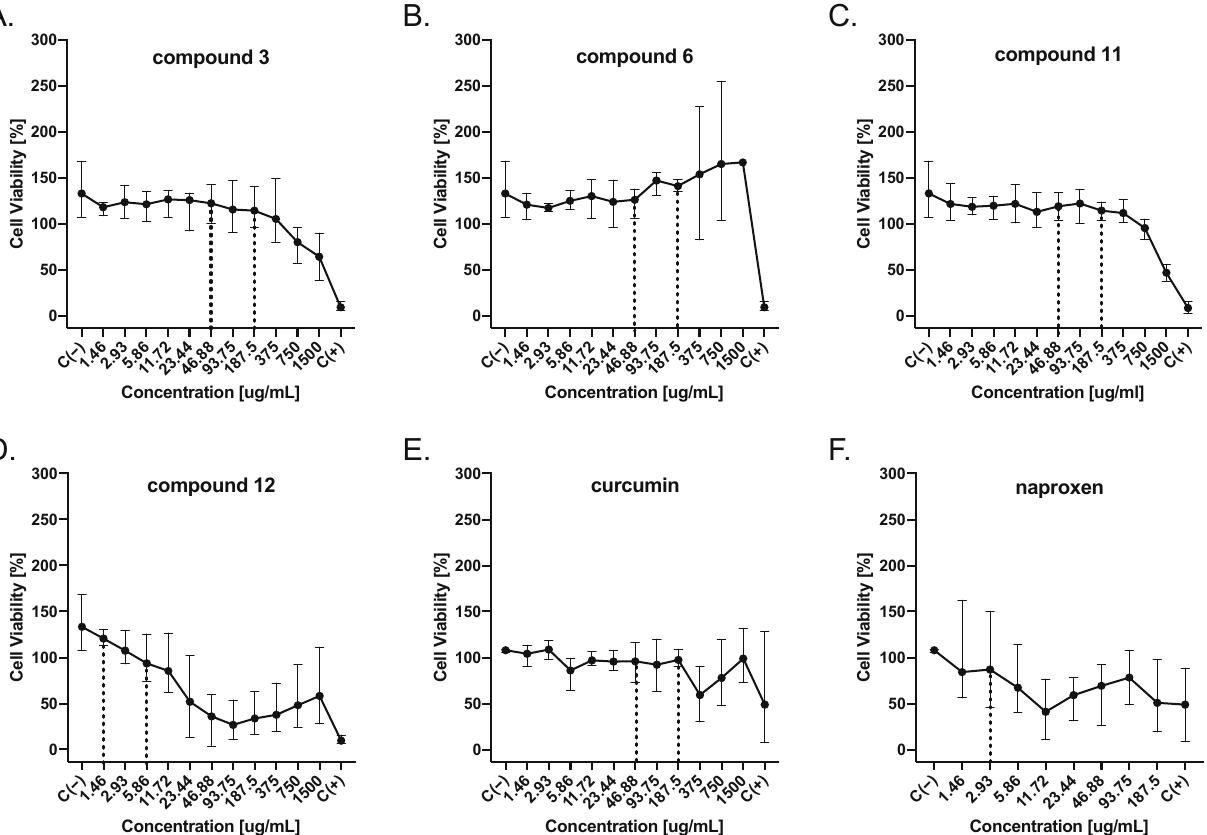
Figure 3. Summary of cytotoxicity analyzes and endotoxin level evaluation. ( A – F ) MTT assay was performed to determine cell viability. Frequency of viable cells after treatment with the monocarbonyl analogs of CUR (namely ( A ) 3 , ( B ) 6 , ( C ) 11 , and ( D ) 12 ), ( E ) CUR, and ( F ) naproxen at different concentrations are presented; C( − ) negative control—cells in vehicle; C(+) positive control—cells in DMSO; dashed lines—range of concentrations selected for functional experiments, n = 3 .